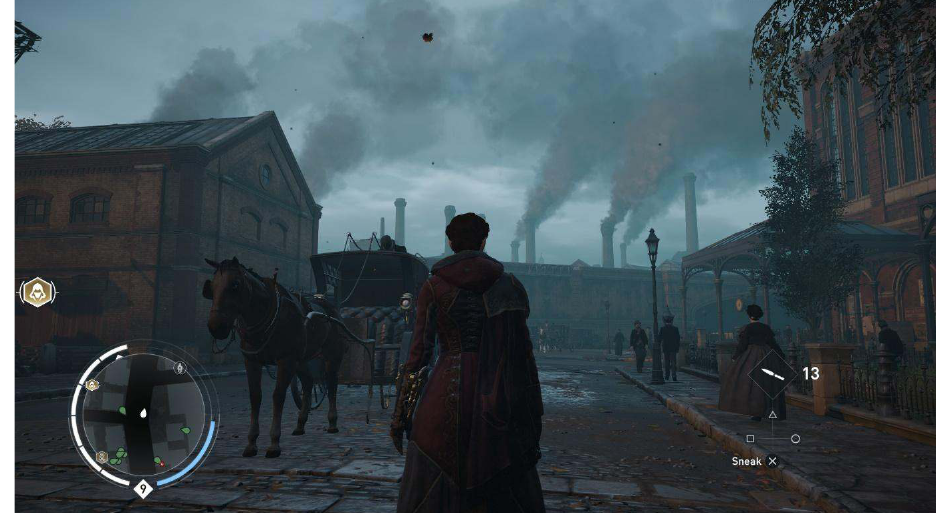
Credits: Assassin’s Creed Syndicate ,